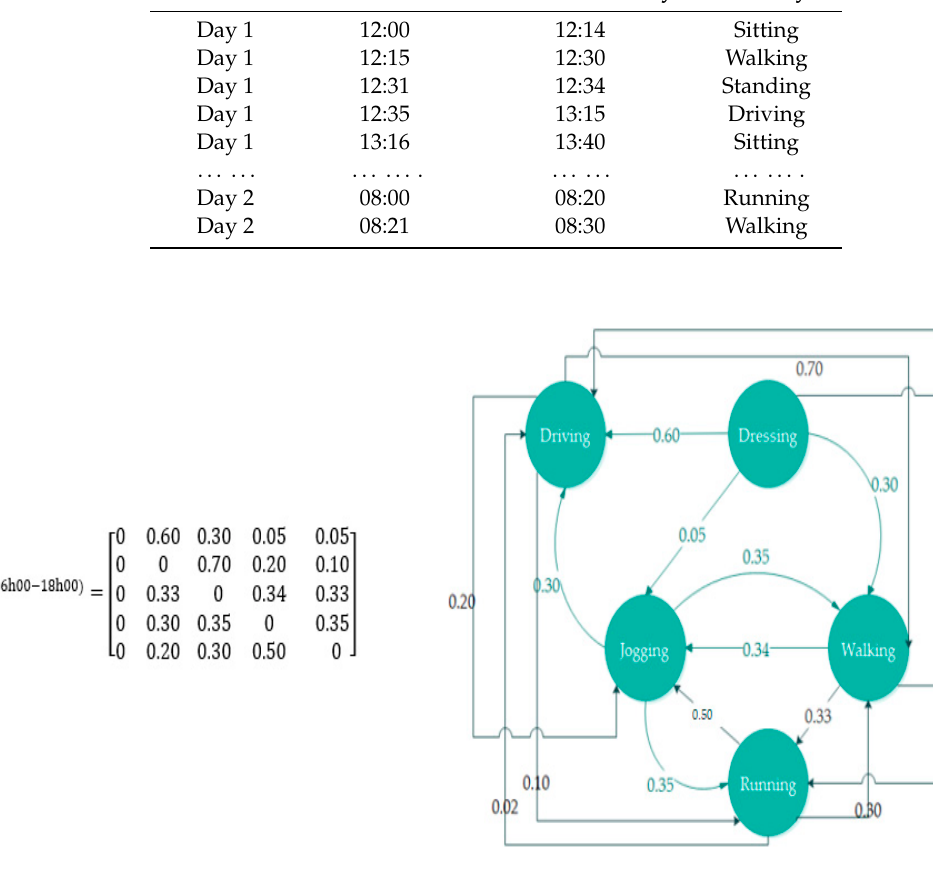
Figure 11. The matrix of transition probabilities.